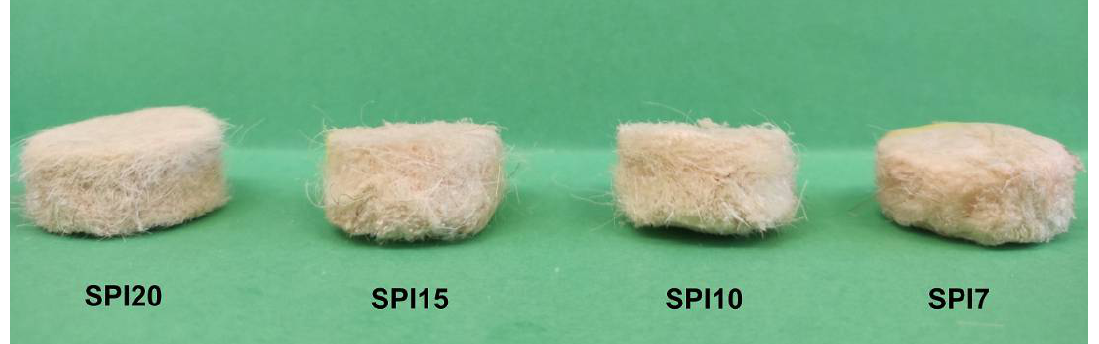
Figure 2. Photo of SPI20, SPI15, SPI 10, and SPI7 biocomposites.